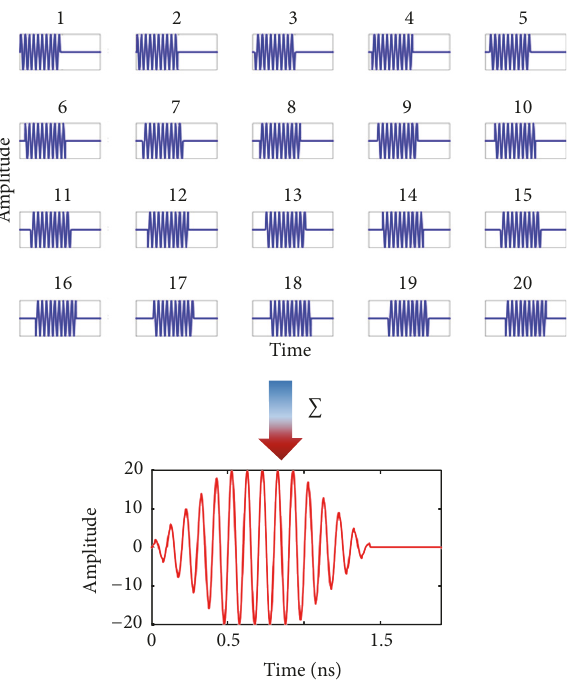
Figure 3: Signal dispersion in a 20-element linear phased array steered to 𝜃 𝑠 = 30 ∘ .